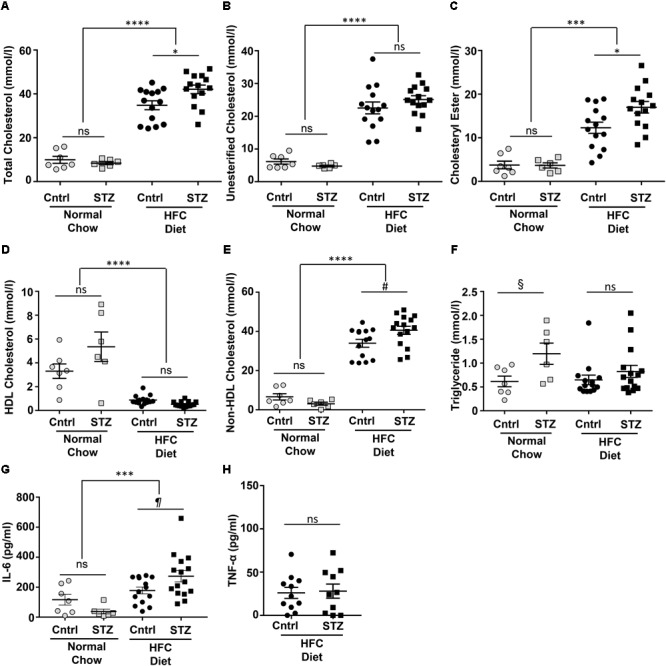
Plasma lipids and IL-6 in control- and STZ-treated SR-B1-KO/hypoE mice fed the normal chow or HFC diets. Mice were fasted for 4 h prior to humane euthanasia under anesthesia, and blood collection by cardiac puncture into heparinized syringes. Plasma was analyzed for total cholesterol (A), unesterified cholesterol (B), cholesteryl ester (total-unesterified cholesterol; C), HDL cholesterol (D), non-HDL cholesterol (total – HDL cholesterol; E), triglycerides (F) IL-6 (G), and TNF-α (H) using commercially available assay kits as described in Section “Materials and Methods.” Circles represent mice treated with control citrate buffer (Cntrl) and squares represent mice treated with STZ. Gray symbols represent mice maintained on normal chow up to 14 weeks after start of control/STZ-treatment and black symbols represent mice switched to HFC diet 3 weeks after start of control/STZ-treatment and analyzed after 4 weeks of HFC diet feeding. Horizontal bars and error bars represent means and SEM. Data were analyzed by one-way ANOVA with the Tukey’s multiple comparisons test; ns indicates not statistically significant; ∗p < 0.05, ∗∗∗p < 0.001; ∗∗∗∗p < 0.00001. Pairwise comparisons indicated by the symbols #, §, and ¶were done using the Mann–Whitney rank sum test. #p = 0.02; §p = 0.051; ¶p = 0.061.